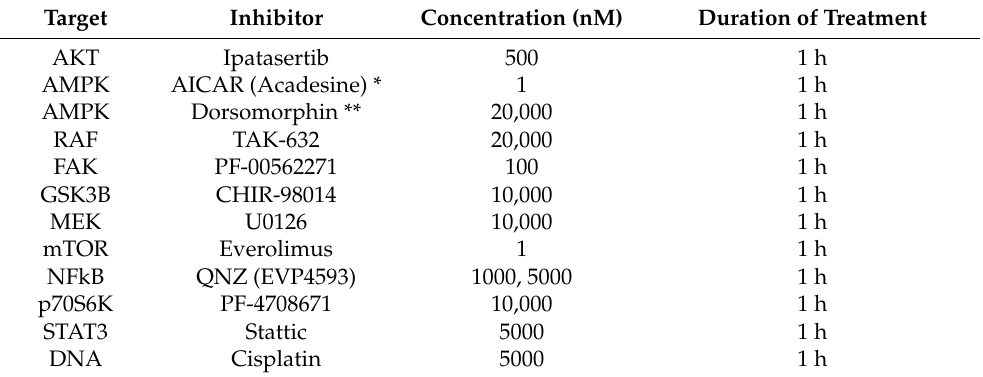
Table 1. Small molecule inhibitors and concentrations used in the reverse-phase protein array